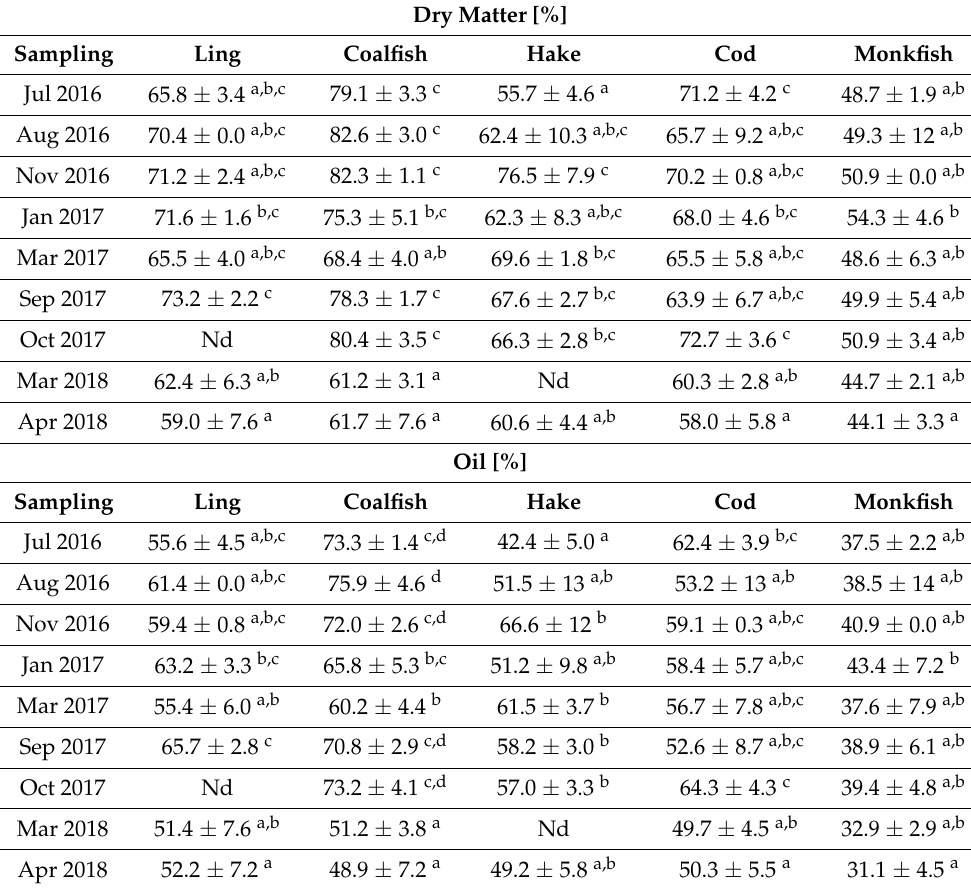
Table 2. Dry matter and oil contents in fish livers sampled at different time points. Dry Matter